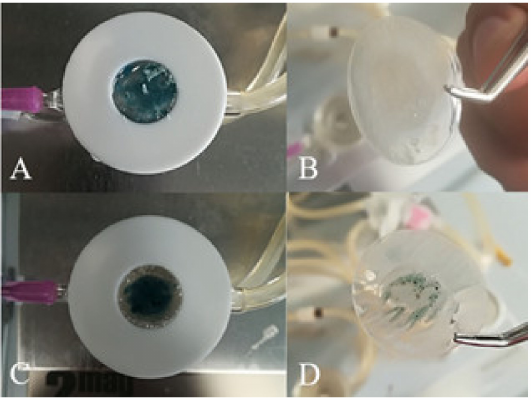
Figure 9. Permeation study—Comparison of Permeapad ® membrane loaded with CM-HSE at t 0 ( A ) and t 360 ( B ); Comparison of Permeapad ® membrane loaded with HSE at t 0 ( C ) and t 360 ( D